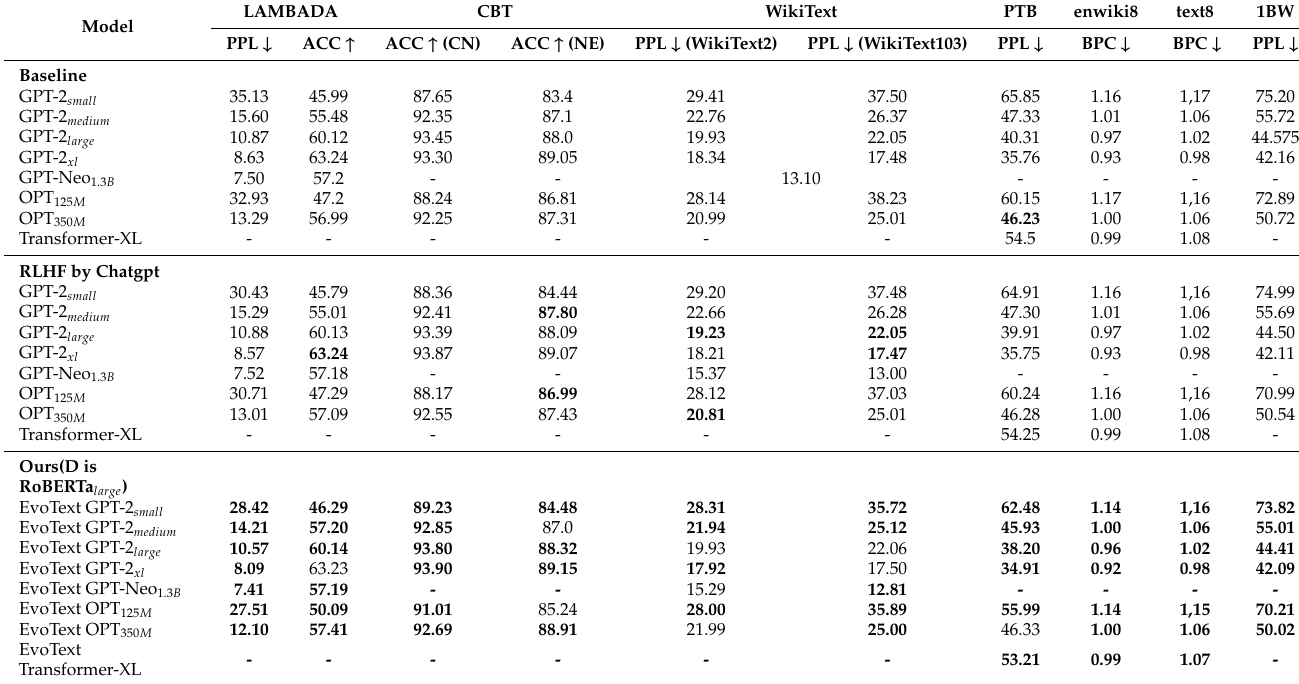
Table 7. ZERO-SHOT performance of the model on 7 natural language processing tasks after 156 minibatch-sized EvoText sessions. Each model was run five times on each task and averaged.